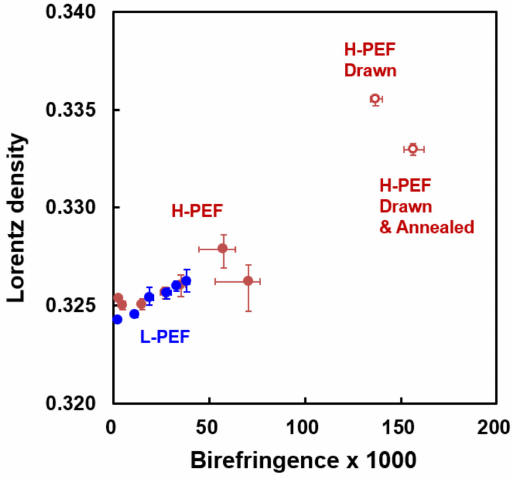
Figure 5. Relation between birefringence and Lorentz density for the high-speed spun L-PEF and H-PEF fibers. The results for the drawn and the drawn and annealed fibers are also shown for